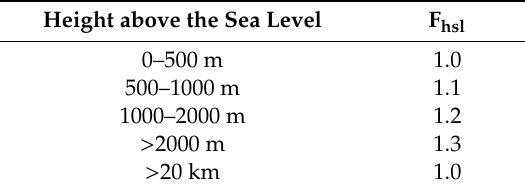
Table 4. Values for height above sea level factors (F hsl ).